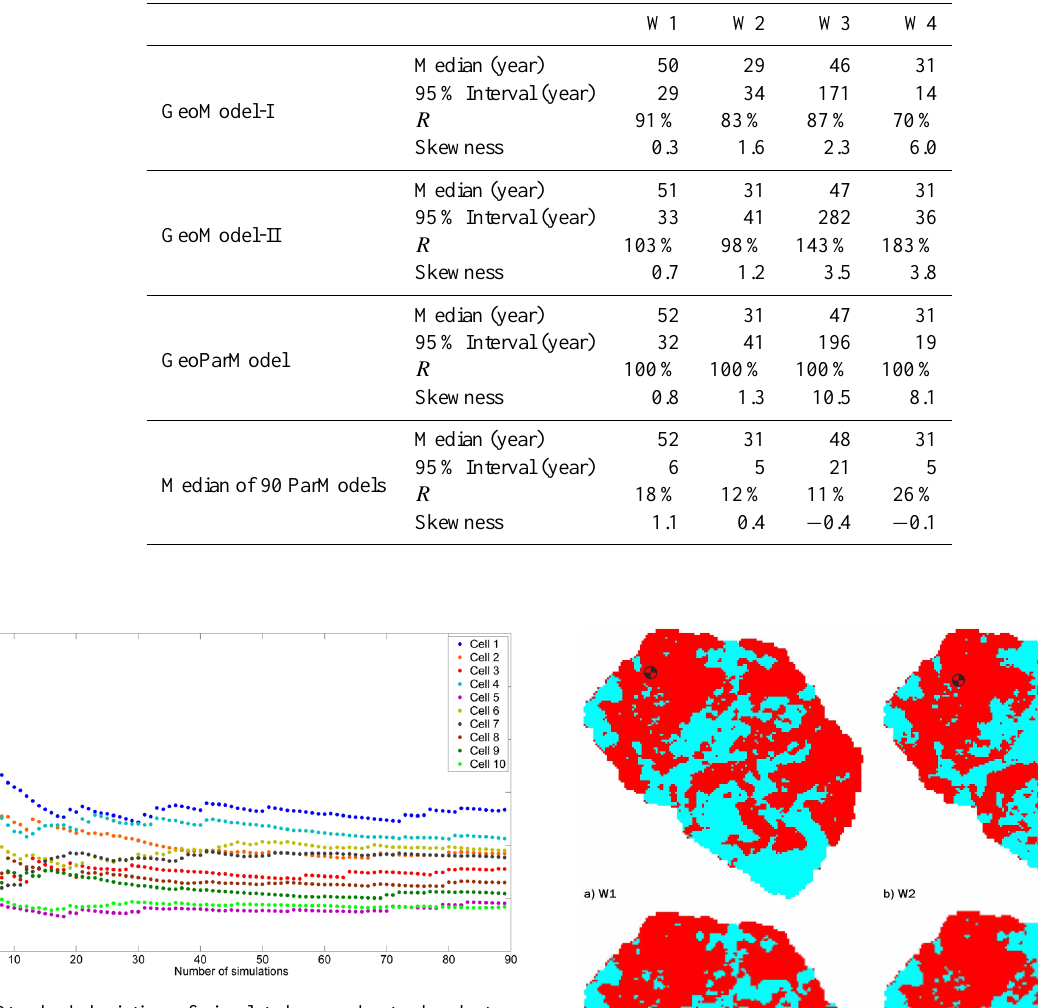
Fig. 7. Standard deviation of simulated groundwater head at se- lected cells (GeoModel-I).